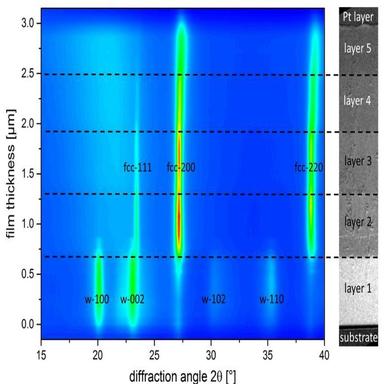
Phase evolution as a function of the thickness of the graded TiAl(O)N film combined with the nitrogen jump ratio image.